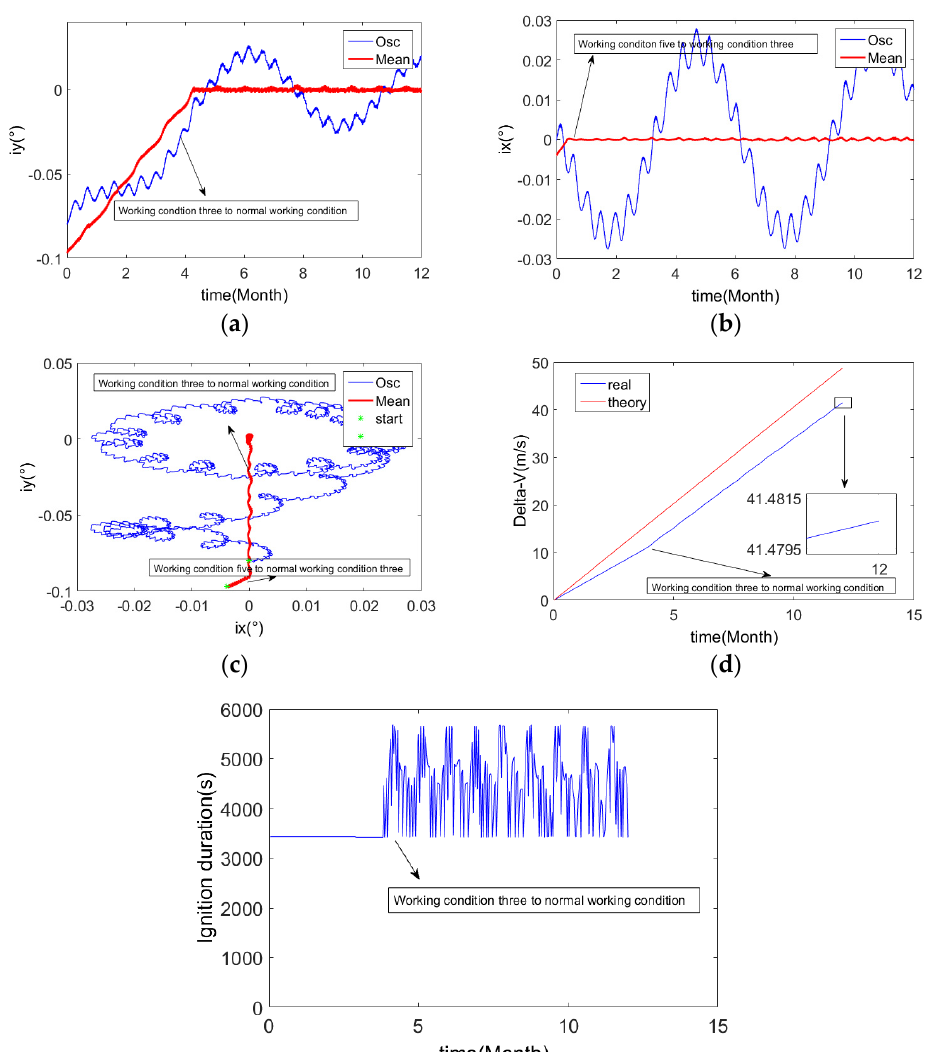
Figure 15. The results of example two. ( a ) Y-axis component of orbital inclination vector; ( b ) X-axis component of orbital inclination vector; ( c ) Orbital inclination vector; ( d ) Velocity increment for SK; ( e ) Duration of SK.